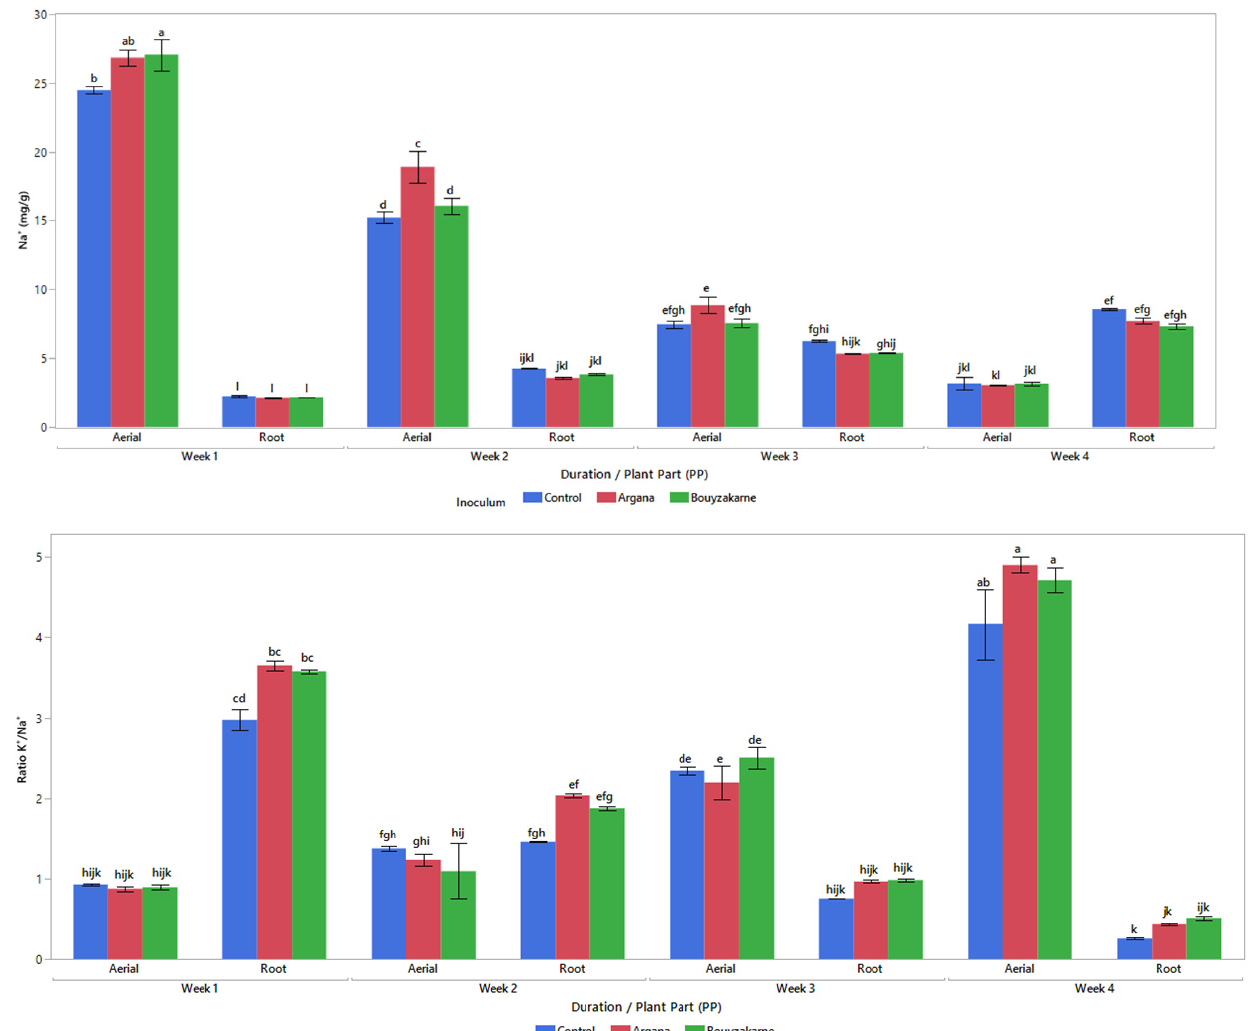
Figure 3. Potassium and sodium ion content and K + /Na + ratio in the leaves and roots of mycorrhizal or non-mycorrhizal Argan plants subjected to soil water deficit stress for one month (each error bar is constructed using 1 standard error from the mean). Values with different letters are significantly different (Tukey’s test p ≤ 0.05).